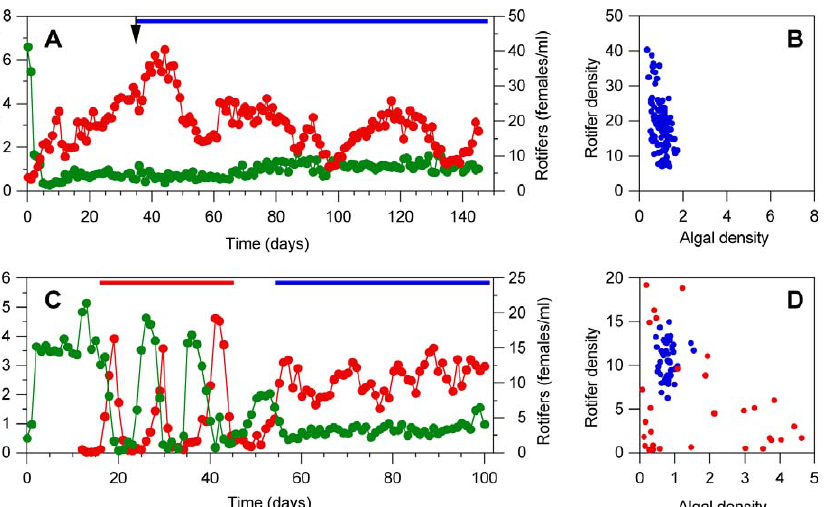
Figure 2. Experimentally Observed Cryptic Population Cycles in Rotifer–Alga Predator–Prey Chemostats (A) Cryptic cycles: algal density (green) stayed relatively constant, whereas rotifer density (red) fluctuated greatly. Dilution rate changed from 0.98 to 0.80 d (cid:2) 1 at day 37. (B) Densities of rotifers and algae are plotted against each other using the part of the time series indicated by the blue line in (A). (C) Transient dynamics leading to cryptic cycles. Before the rotifer population (red) was established, algal density (green) was kept high (day 0–15). Short predator–prey cycles were observed from day 16–45 (delineated by red line), presumably because a single clone dominated the algal population. Then, cryptic cycles were observed from day 55–100 (delineated by blue line). Dilution rate was 0.84 d (cid:2) 1 throughout. The estimated period of cycling, using spectral analysis for days 59–93, is 16.5 d ([52], periodicity significant at p , 0.001 using either Fisher’s exact test or v 2 test). (D) Densities of rotifers and algae are plotted against each other; red and blue circles correspond to the time periods indicated by red and blue lines in (C).